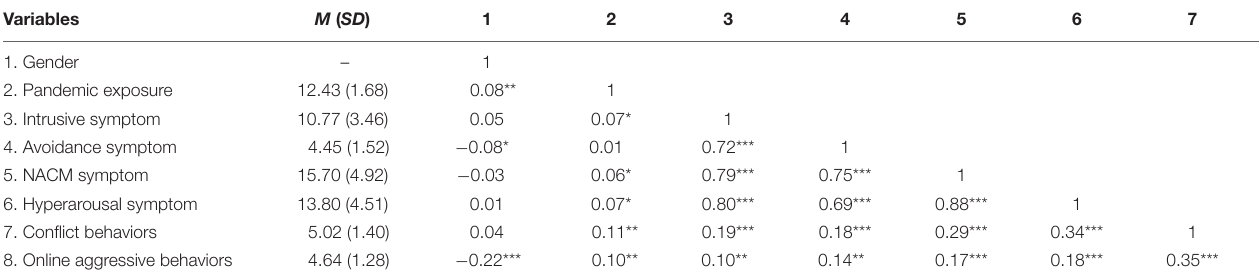
TABLE 1 | Descriptive statistics and correlations among main variables.